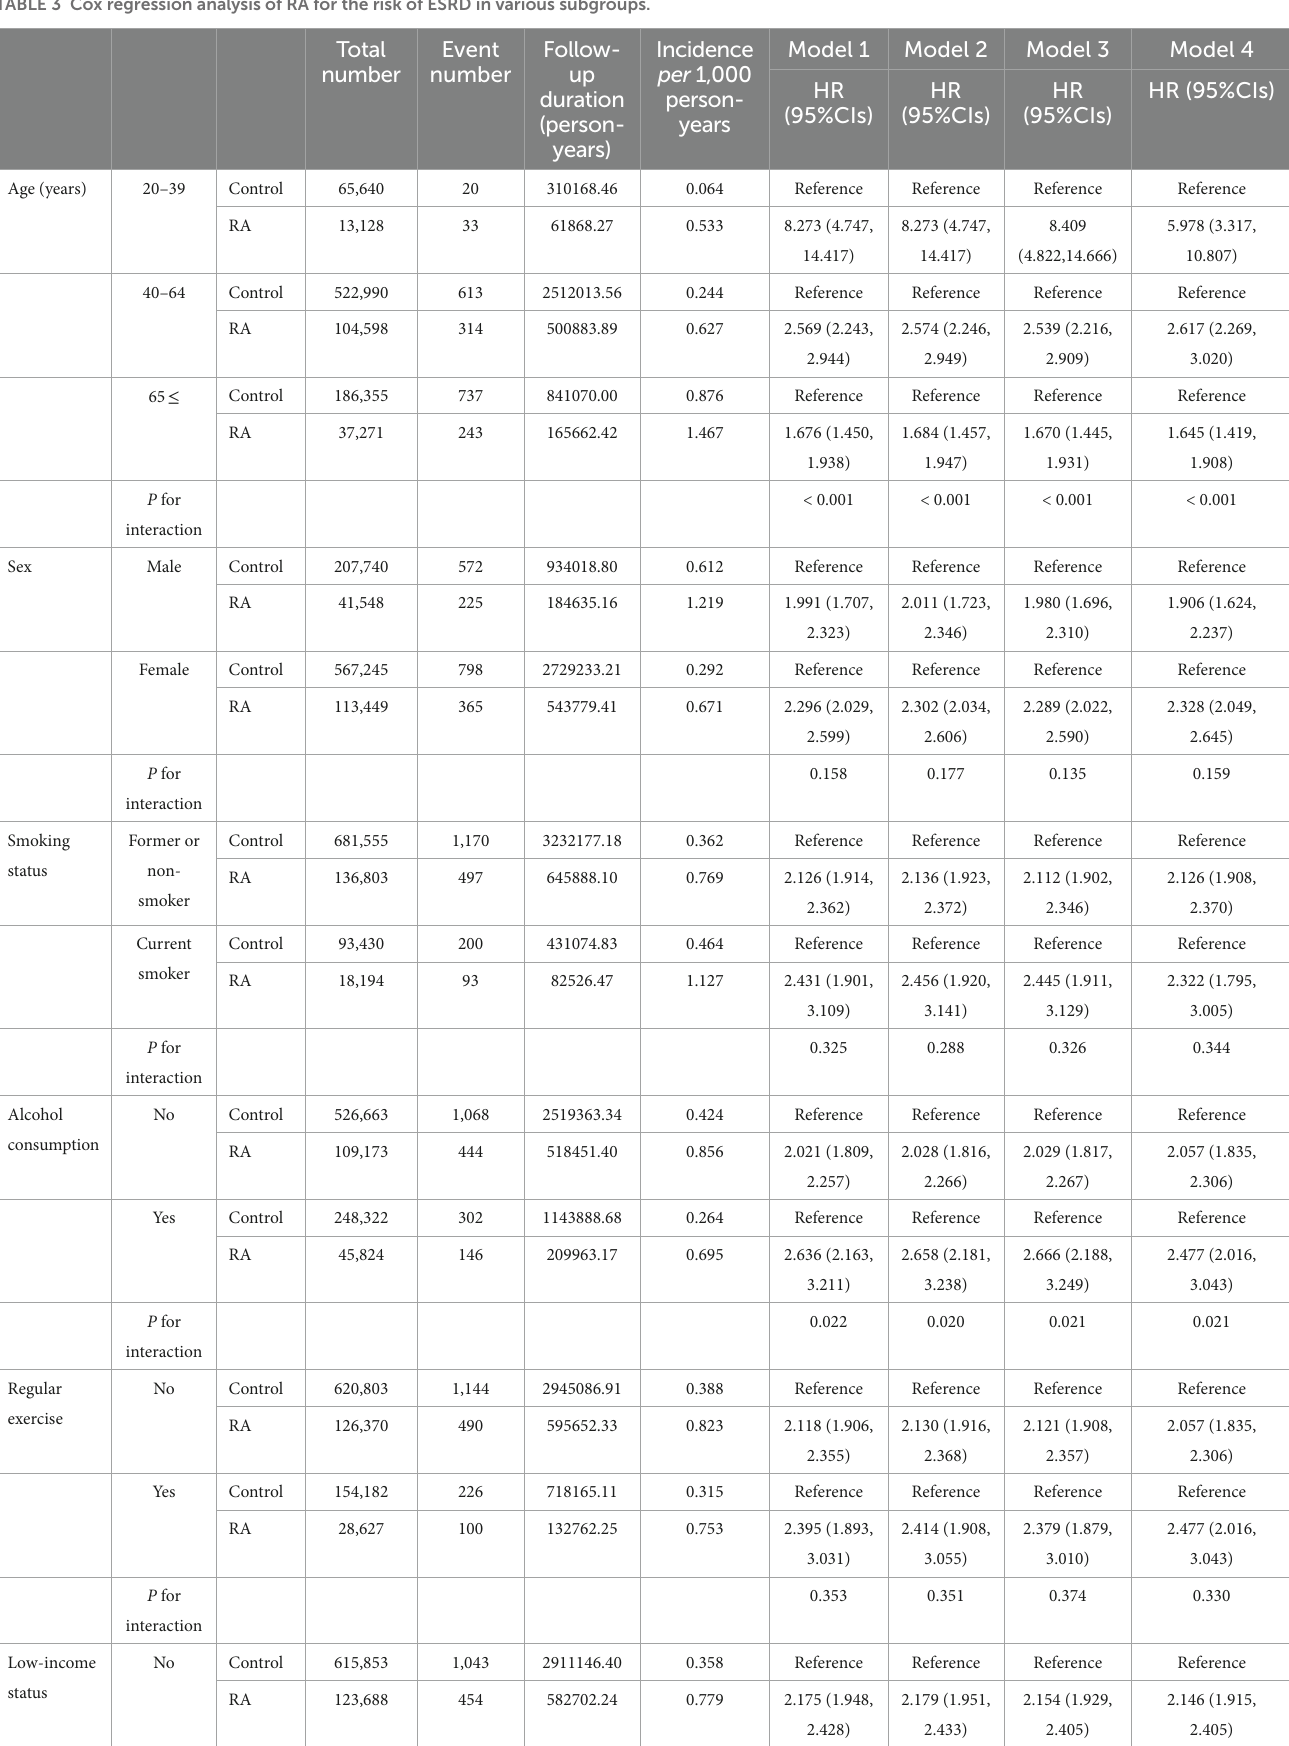
TABLE 3 Cox regression analysis of RA for the risk of ESRD in various